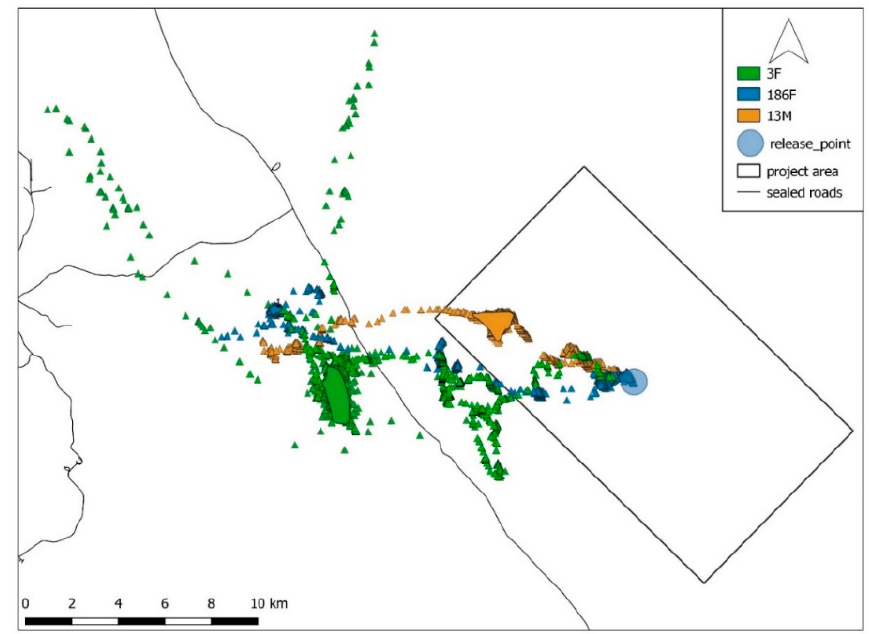
Figure A3. Post-release movements of three western grey kangaroos that survived > 5 days (half-hourly intervals) but died during study.